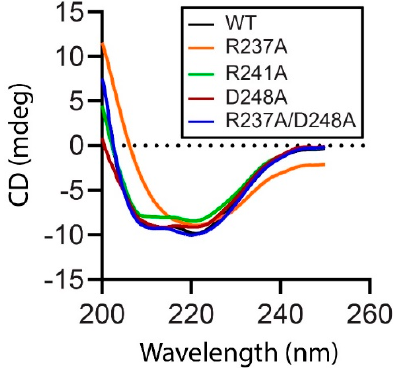
Figure 7. CD spectra of WT and mutant PML